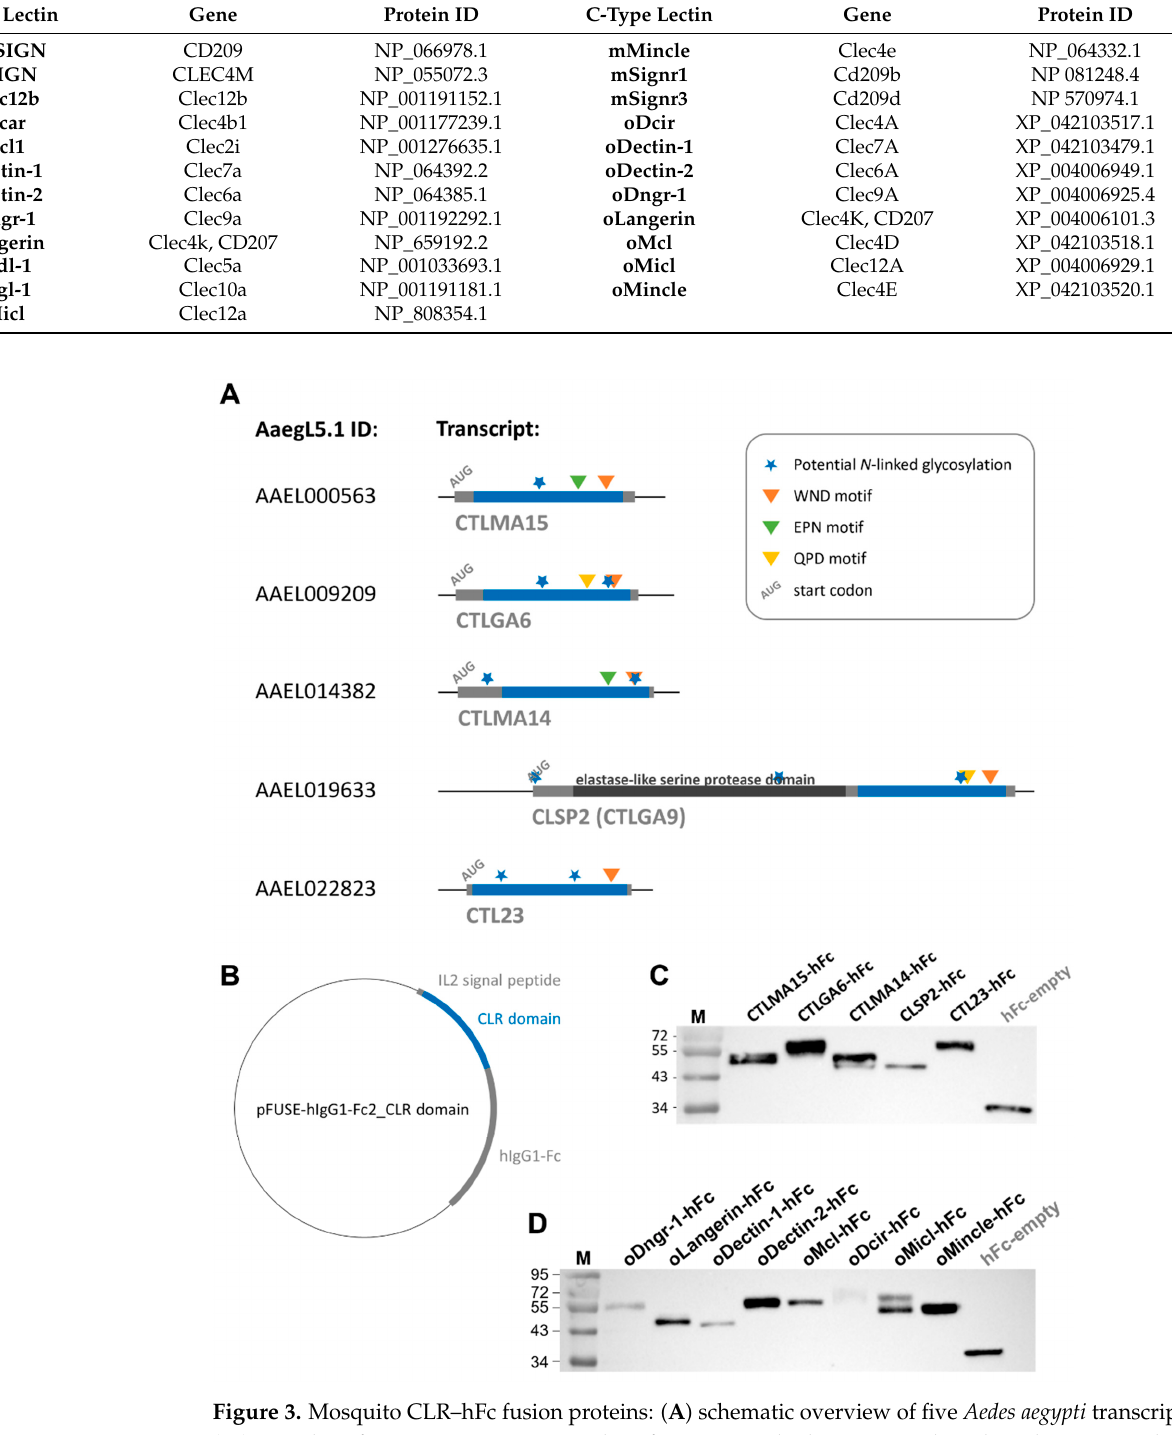
Figure 3. Mosquito CLR–hFc fusion proteins: ( A ) schematic overview of five Aedes aegypti transcripts (—) encoding for CTLDcps. Open reading frame is marked in grey, and nucleotides extracted for produced hFc–fusion proteins are highlighted in blue. Start codon and four conserved genetic motifs symbolised, as shown in the legend. AaedL5.1 CLR nucleotide sequences were obtained from VectorBase; ( B ) vector map of CLR domain ligated into pFUSE–hIgG1–Fc2 (Invitrogen); ( C , D ) Western blot image of anti-hFc stained mosquito ( C ) and ovine ( D ) CLR–hFc fusion proteins and hFc-empty control. Lane M: protein molecular standard, in kDa.